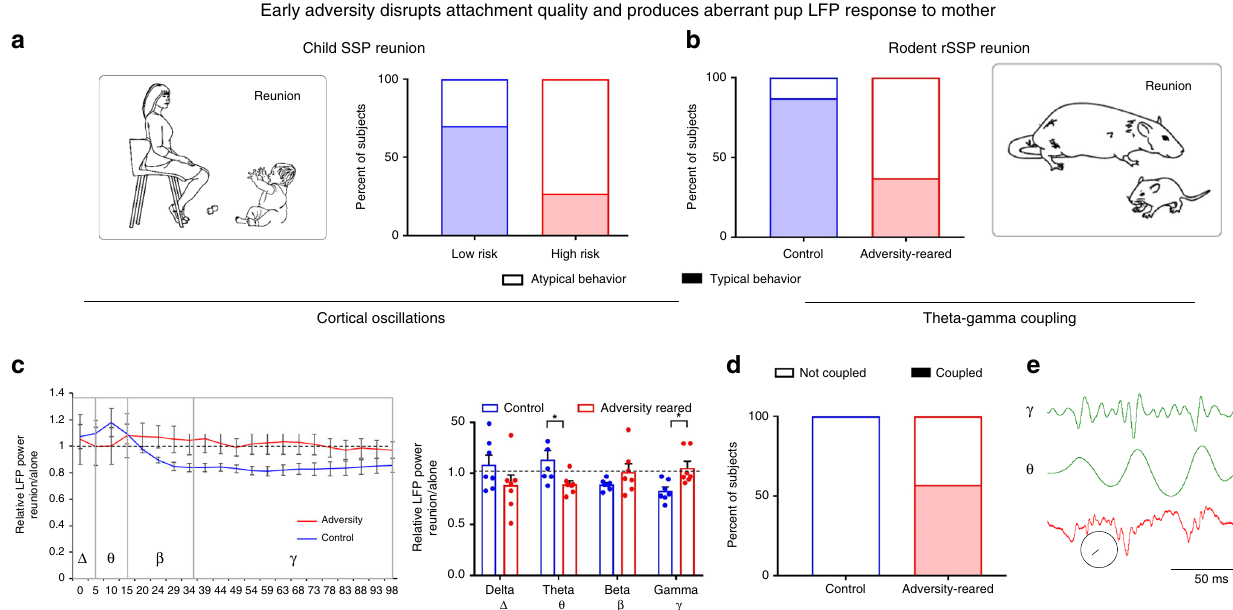
Fig. 3 Across species, compromised early care disrupts attachment uncovered by separation and reunion with the caregiver in the SSP. a In children, biographical factors (e.g., SES and housing stability) generated classi fi cations of risk. During the SSP, prosocial behaviors were observed more often in low- risk children, while atypical reunion behaviors were more frequently observed in high-risk children. b Adversity-reared rat pups showed atypical responses to the caregiver during the SSP reunion epoch. Across species, atypical reunion behaviors observed in the child SSP and rodent rSSP included contradictory responses to the parent or misdirected behaviors. c In rat pups, reunion with the mother decreased high frequency oscillations in the control-reared pups (normalized to power during epoch 5: pup alone, data from 5 control and 5 adversity-reared litters). This decrease was not observed in adversity-reared pups; unlike controls, theta power was decreased. Bars represent mean ± standard error (SEM) of power collapsed into frequency bands. Dashed line = no change from pup alone. Frequency bands labeled are delta ( δ ), theta ( θ ), beta ( β ), and gamma ( γ ). d In rat pups, theta-gamma coupling was observed more reliably in adversity-reared pups than control-reared pups. e Rat pup example of raw voltage trace (red) and gamma ( γ )/theta ( θ ) fi lters (green); scale bar: vertical is 10 µ V in theta/gamma, 25 µ V in raw trace. Circle shows phase locking vector length = 0.0581, − 122.36°. * p < 0.05, ANOVA. Source data are provided as a Source Data fi